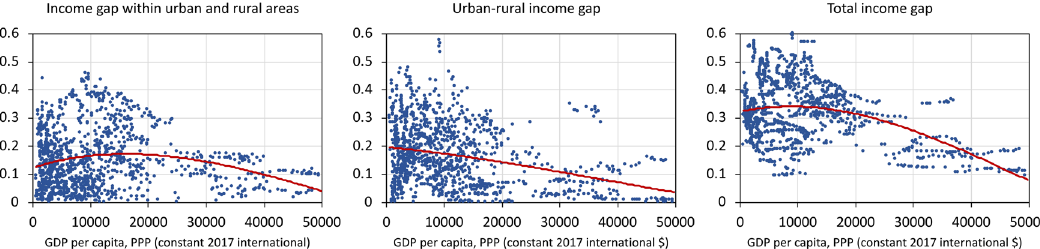
Fig. 7 GDP-Income gap relationship by 90 economies from 1990 – 2017. Note: This plots the correlations between GDP per capita and income gap using 1990 – 2017 data from 90